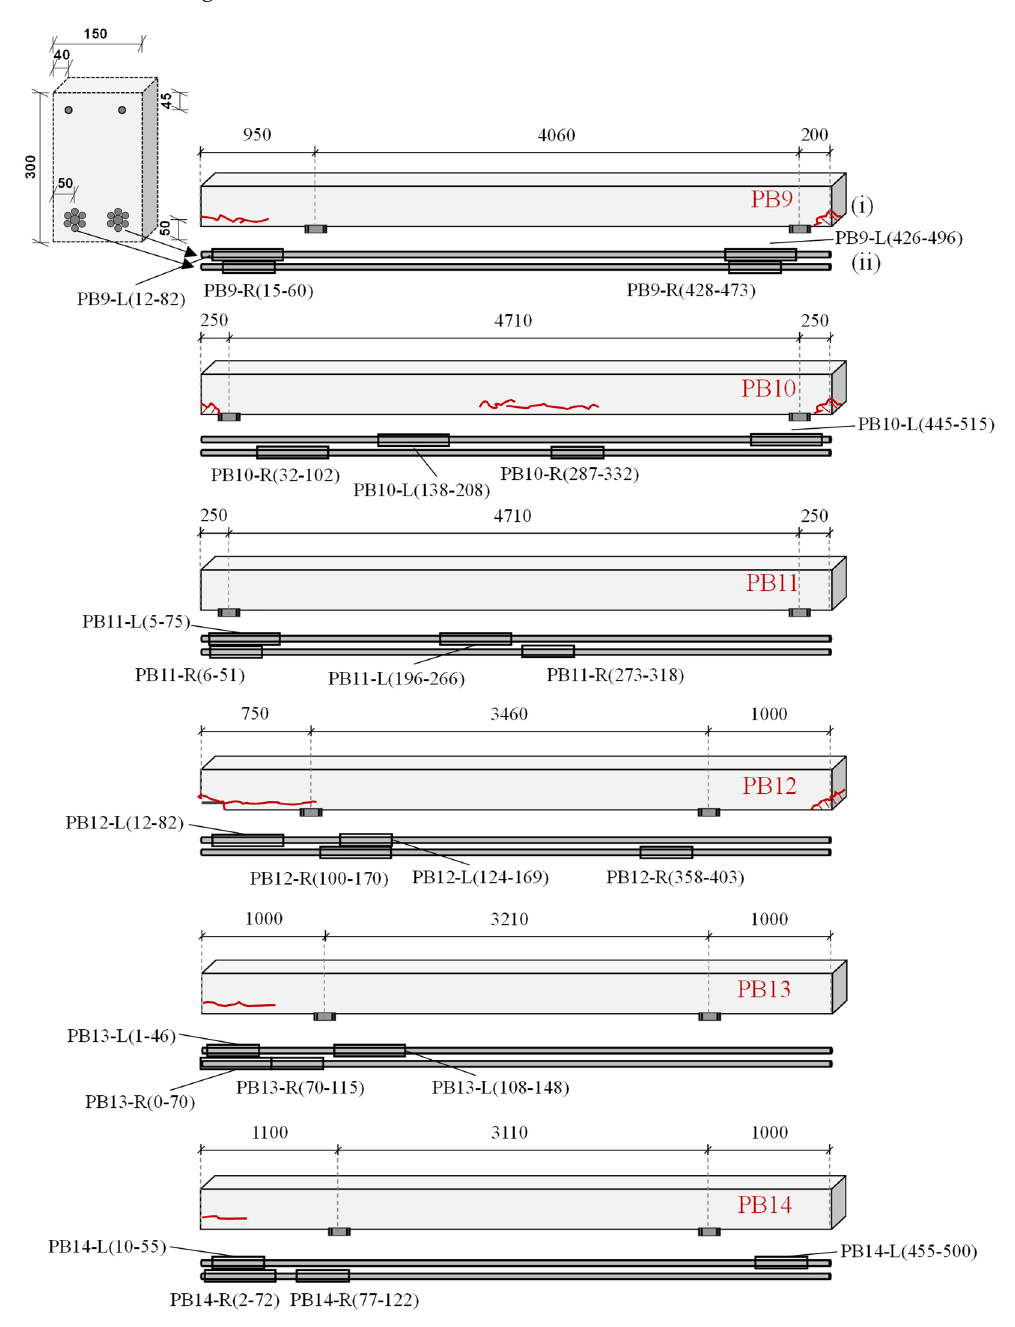
Figure 1. Features of corroded PC beams: ( i ) identification of corrosion-induced longitudinal split- ting cracks, ( ii ) samples’